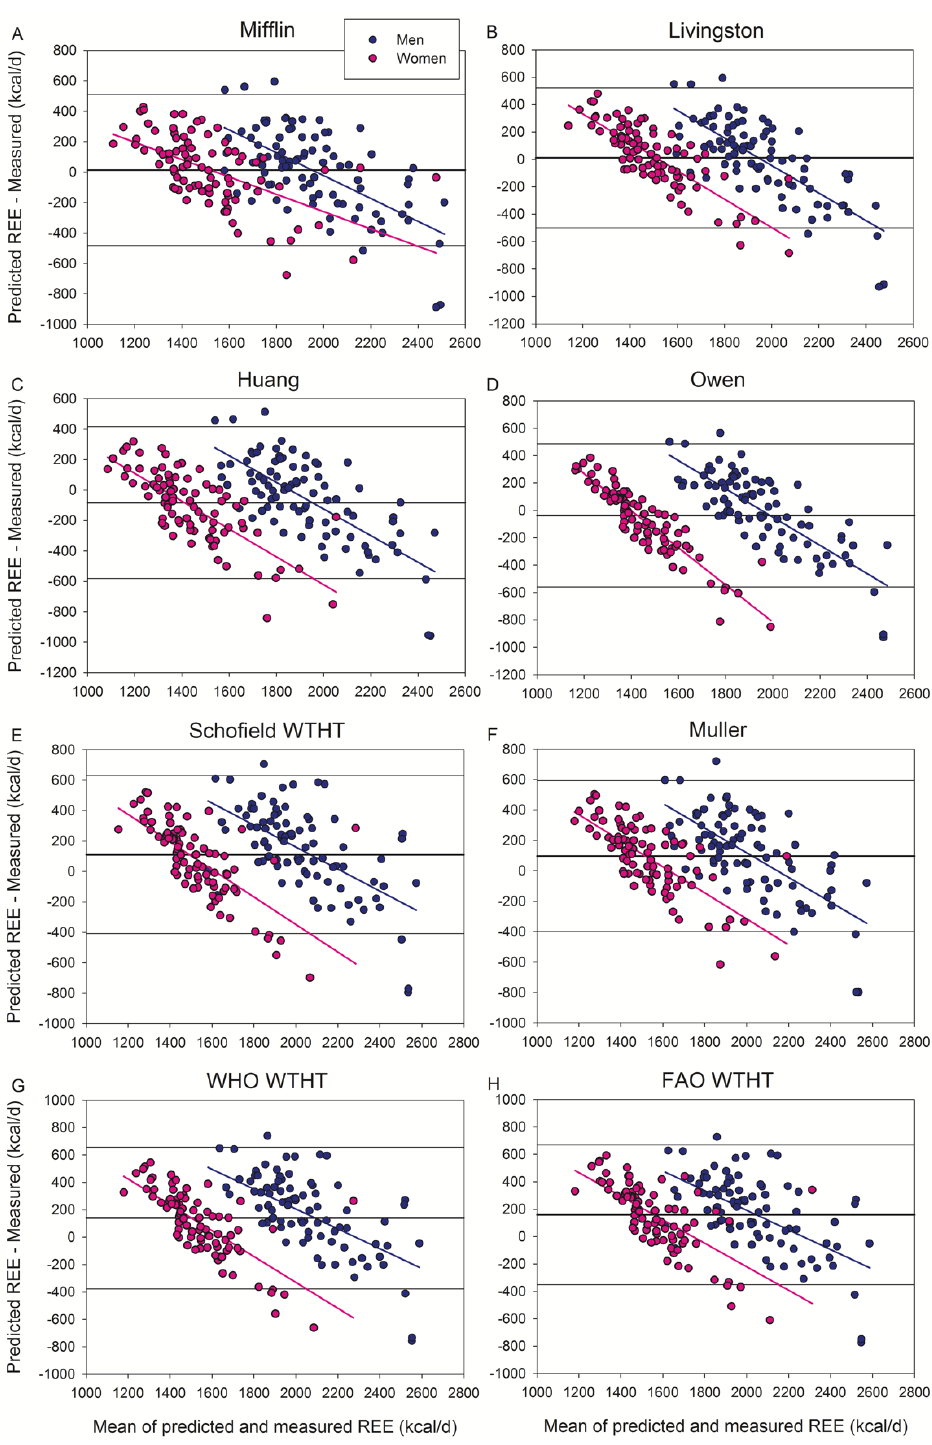
Figure 1. Bland–Altman plots displaying the agreement between measured and predicted REE by the equations of ( A ) Mifflin, ( B ) Livingston, ( C ) Huang, ( D ) Owen, ( E ) Schofield WTHT, ( F ) Muller, ( G ) WHO WTHT, and ( H ) FAO WTHT. All these equations included obese subjects in their populations. The thick continuous line indicates the mean value of the differences between predicted and measured REE (bias). The thin lines delimit the 95% confidence interval. All the regression lines were statistically significant at p < 0.001, indicating a systematic bias. Note that “Y” and “X” axes have different scales.